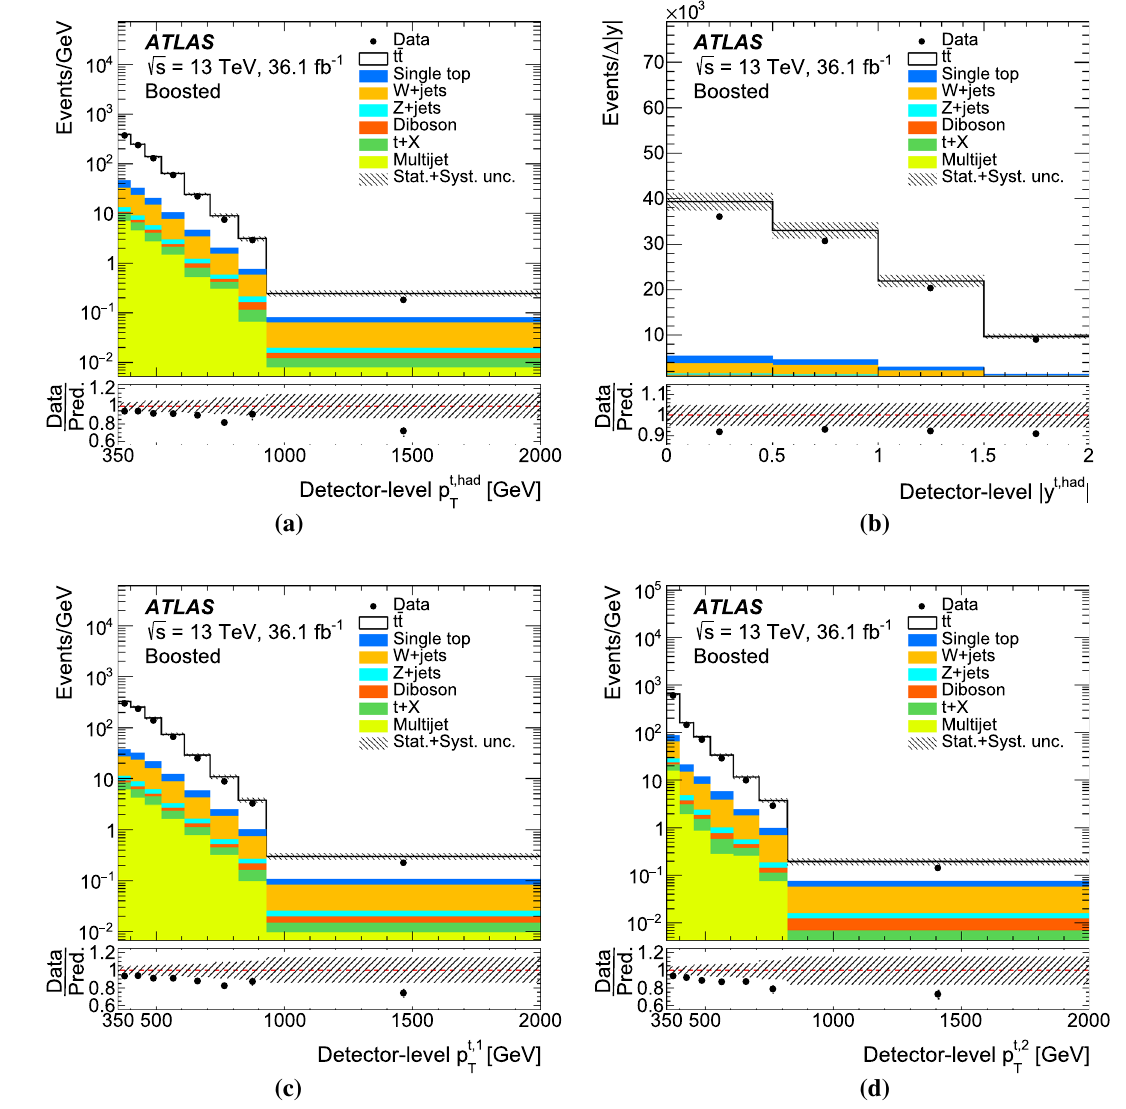
Fig. 8 Distributionsofobservablesinthe (cid:3) + jetschannelintheboosted topology at detector-level: a transverse momentum and b absolute value of the rapidity of the hadronic top quark, c transverse momen- tum of the leading top quark and d transverse momentum of the sub- leading top quark. Data distributions are compared with predictions, using Powheg + Pythia8 as the t ¯ t signal model. The hatched area rep-